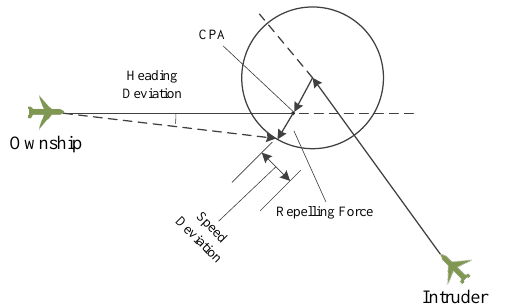
Figure 15. MVP resolution advisory based on geometry at CPA. Reprint from